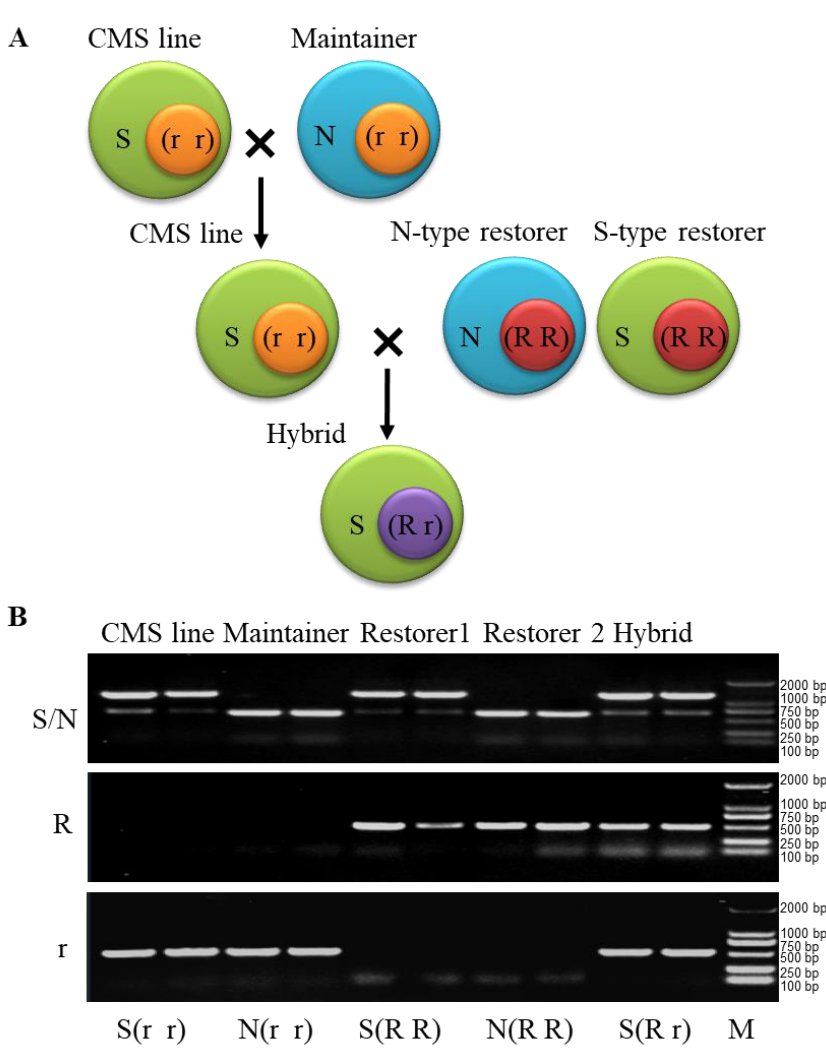
Figure 2. Identification of CMS three lines and its hybrids in B. napus by the molecular markers. ( A ) Schematic diagram of genetic pattern of CMS three lines and their hybrids in B. napus . ( B ) Identifi- cation of CMS three lines and their hybrids in B. napus by the molecular markers. N, fertile cytoplasm gene N; S, sterile cytoplasm gene S; R, fertility nuclear restorer gene; r, recessive nuclear sterile gene; M, DNA marker.